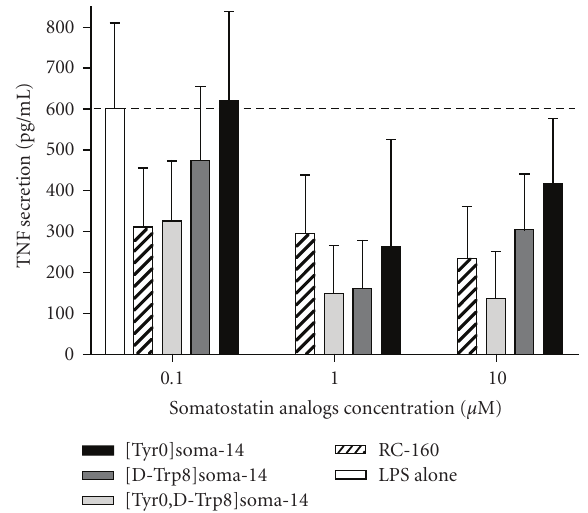
Figure 2: Inflammatory response (TNF- α secretion) of CD patient’s PBMCs in presence of somatostatin analogs. CD patients PBMCs (5 · 10 5 cells/mL) were activated by LPS for 24 hours in presence of increasing doses of somatostatin analogs (10 − 7 M to 10 − 5 M). Quantitative evaluation of the secreted cytokine TNF- α was done by sandwich ELISA as described in Materials and